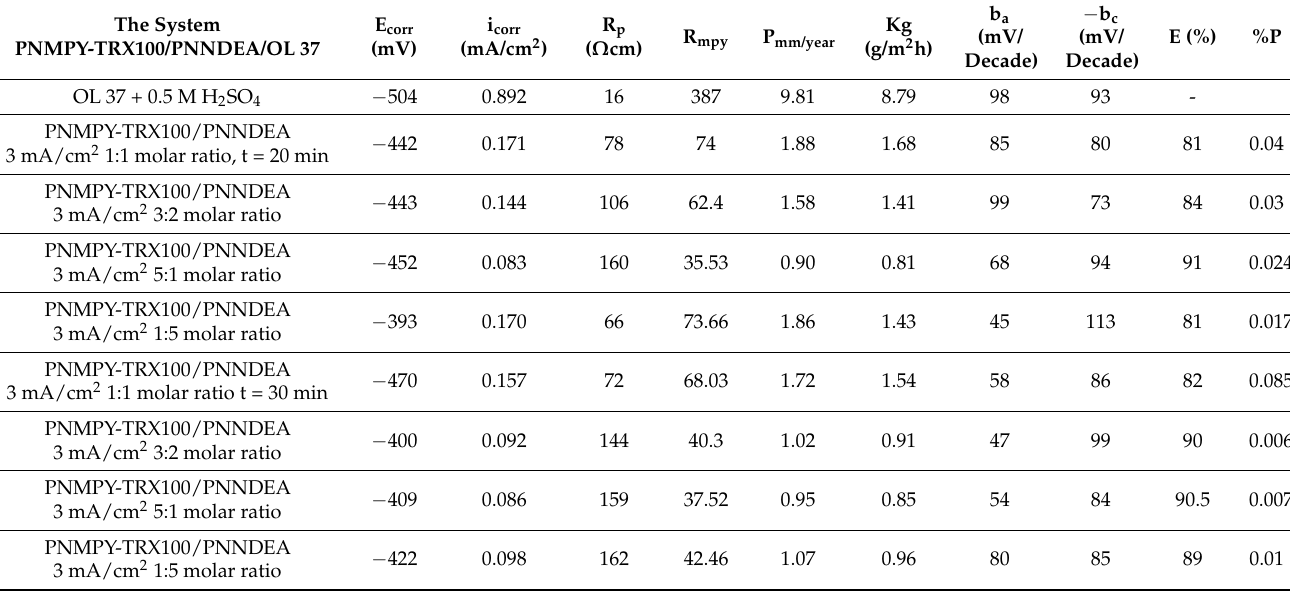
Table 1. Kinetic Corrosion Parameters of Coated and Uncoated OL37 Electrode in 0.5 M H 2 SO 4 Solution at 25 ◦ C. The System PNMPY-TRX100/PNNDEA/OL 37 OL 37 + 0.5 M H 2 SO 4